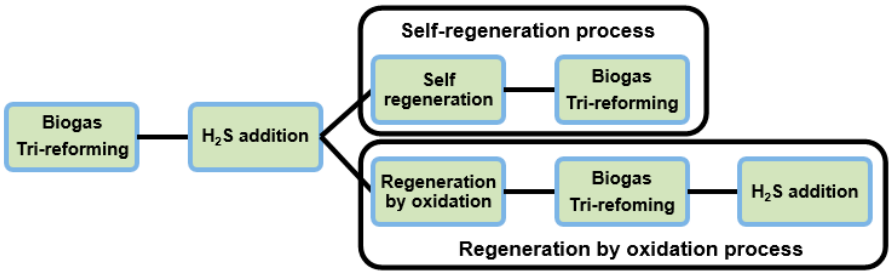
Figure 4. Scheme of the processes studied.